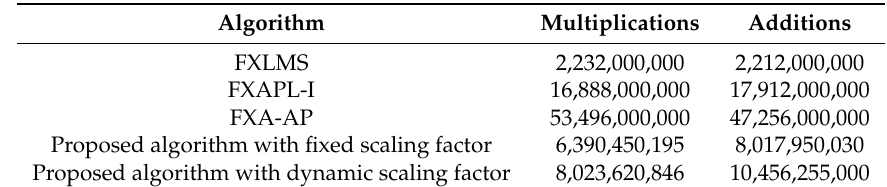
Figure 5. Learning curves of the FXAPL-I algorithm, the FXLMS algorithm, the FXA-AP algorithm and the proposed algorithm as measured at error sensor 1 for a multitonal input. Table 10. Total number of multiplications and additions of the FXAPL-I, FXLMS, FXA-AP and the proposed algorithms for a multi-channel ANC system using a multitonal noise